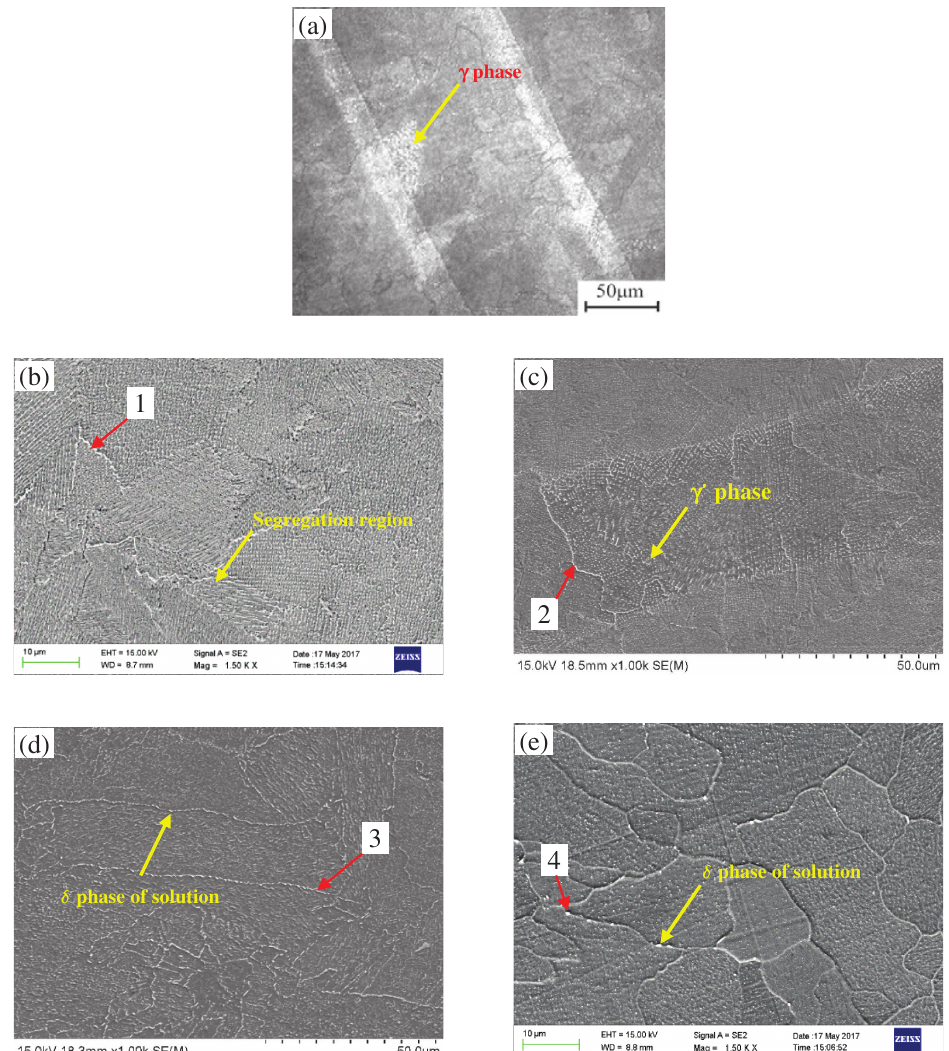
Figure 3: SEM morphology of Inconel 718 alloys under different conditions: (a) Optical microscope of the as-built alloy, (b) SEM morphology of the as-built alloy, (c) SEM morphology of A process, (d) SEM morphology of B process and (e) SEM morphology of C process.